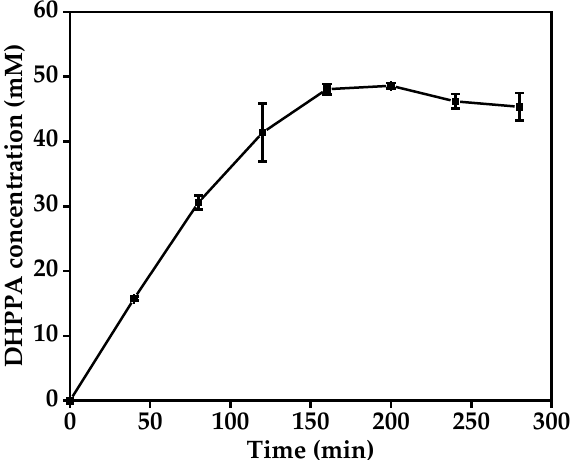
Figure 4. Time profile for the production of DHPPA from L -DOPA using BL21(DE3)-pET-28a- mlaad whole-cell catalysts under optimal conditions. Data represent the means ± SD from three independent determinations.